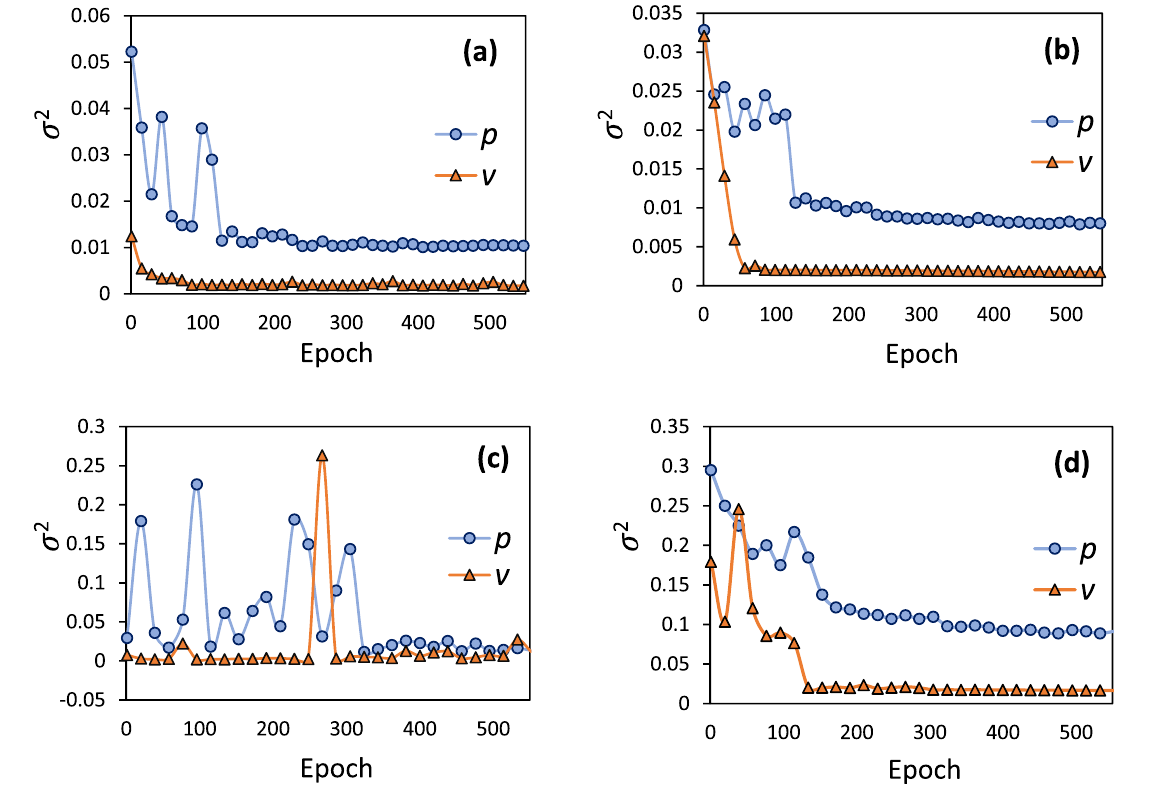
Fig. 1 Computational ef fi ciency of the PIRED. Comparison of cost function σ 2 for the training and testing of the PIRED ( a , b ) and the DDML networks ( c , d